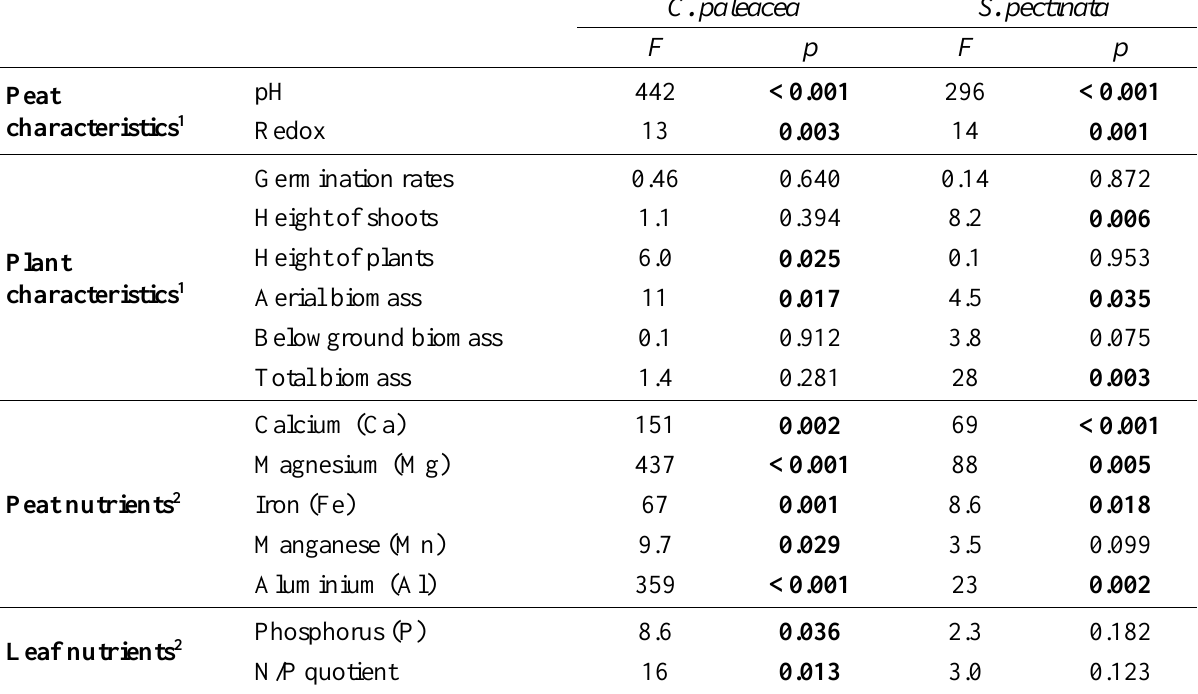
Table A4. Results of ANOVA testing for the effect of liming on peat chemical characteristics, plant characteristics, peat nutrients and leaf nutrients in the greenhouse experiment. Only nutrients for which statistically significant differences were observed are presented. C. paleacea and S. pectinata were not directly compared because their morphologies are different. Significant p values are shown in bold